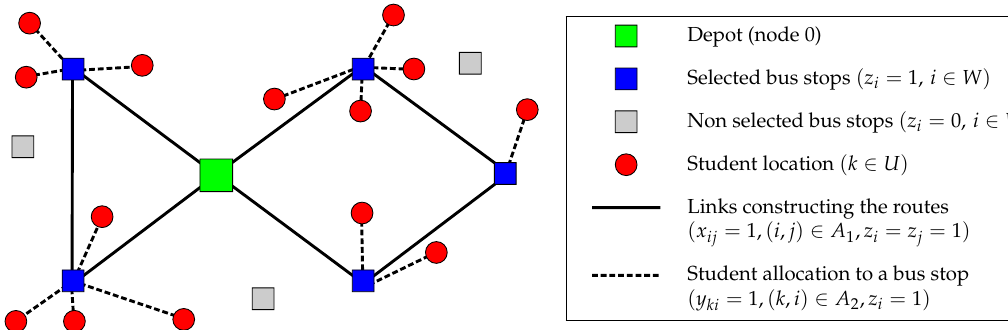
Figure 1. A feasible solution of the School Bus Routing problem with bus stop selection and a maximum walking distance constraint